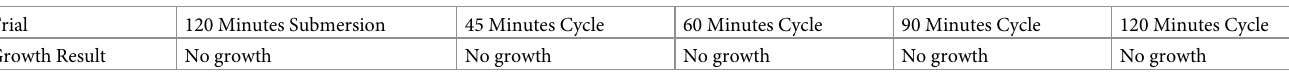
Table 5. BI growth at 7 days following exposure to 12% H 2 O 2